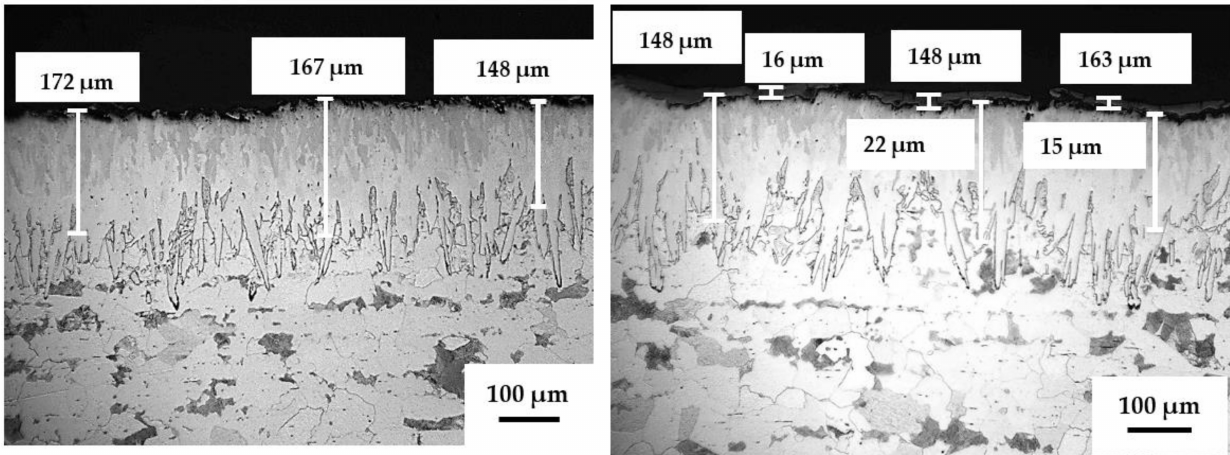
Figure 9. Microstructure of boronized carbon steel (B)—left, and boronized carbon steel with TiO 2 top layer (BT)—right after exposure in H 2 S—air at 500 ◦ C for 504